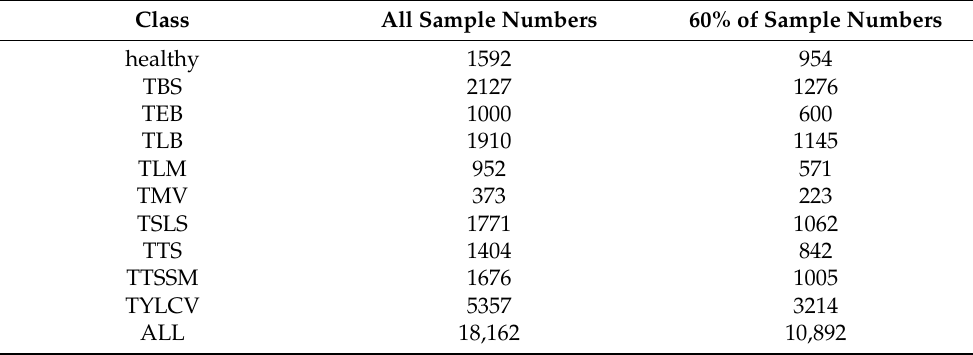
Table 4. Detailed information of the tomato leaf disease